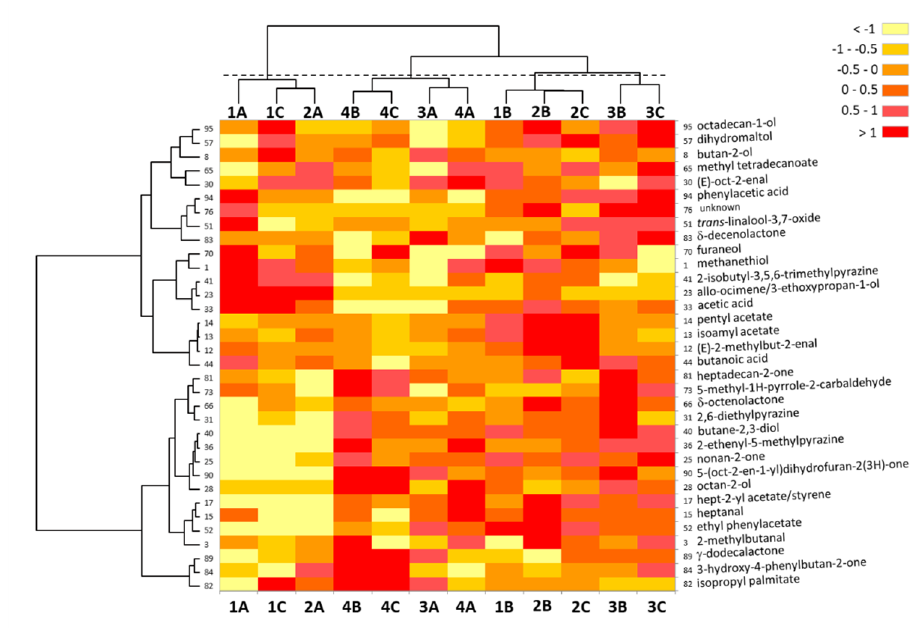
Figure 2. Heatmap displaying the results of a hierarchical cluster analysis (HCA) conducted independently on both samples’ and variables’ (OAs) dimensions, for the 34 discriminant OAs. NIF values’ importance varies from > 1 (highest value, in red) to < − 1 (lowest values, in yellow). OA numbers are those found in Table 1. An HCA conducted on only samples showing the 4 distinctive clusters displayed here may be found in Appendix B (Figure A3) for clarity purposes. The data were centered and scaled; dissimilarity Euclidian distances were used with the Ward amalgamation method.